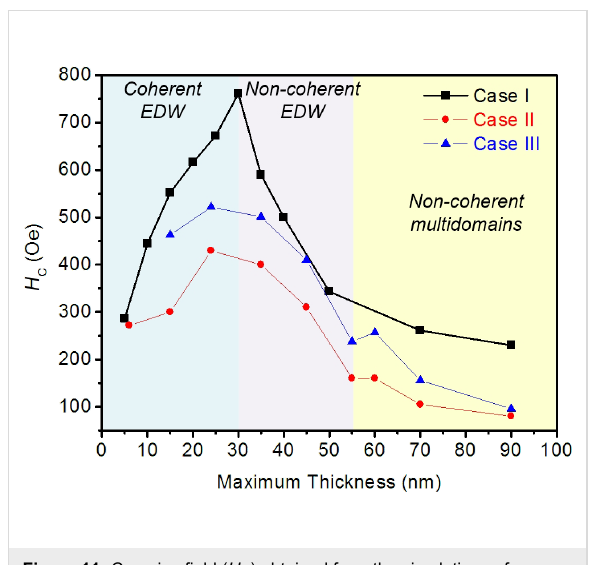
Figure 11: Coercive field ( H C ) obtained from the simulations of nanowires as a function of t Max for the three cases.